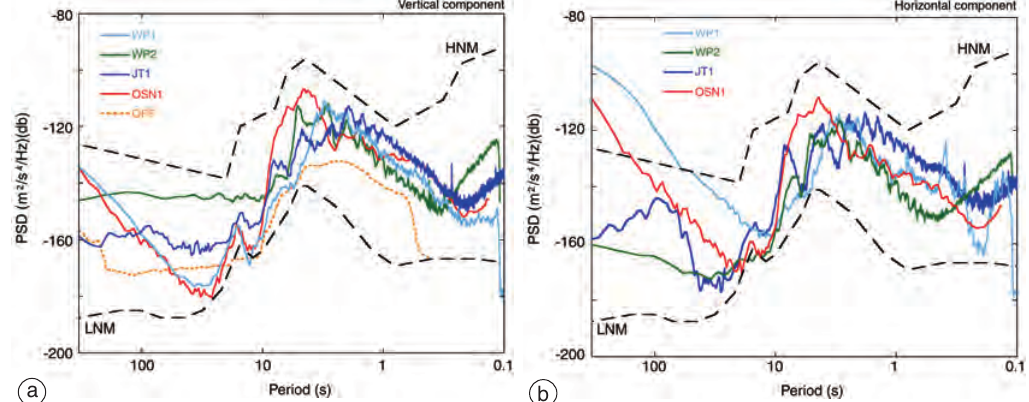
Fig. 13a,b. Comparison of ambient seismic noises between the station in this study and those in previous stud- ies: a) for vertical component; b) for horizontal component. OFP and OSN-1 indicate borehole observatories in North Atlantic Ocean (Montagner, 1994) and the Pacific Ocean off Hawaii (Stephen et al. , 1999), respectively. At present, observations at both these stations have been discontinued. HNM and LNM indicate the high noise model and the low noise model by Peterson (1993), respectively. The noise levels of the WP-1 and WP-2 obser- vatories are comparable with those of the previous studies. There is no horizontal record for the